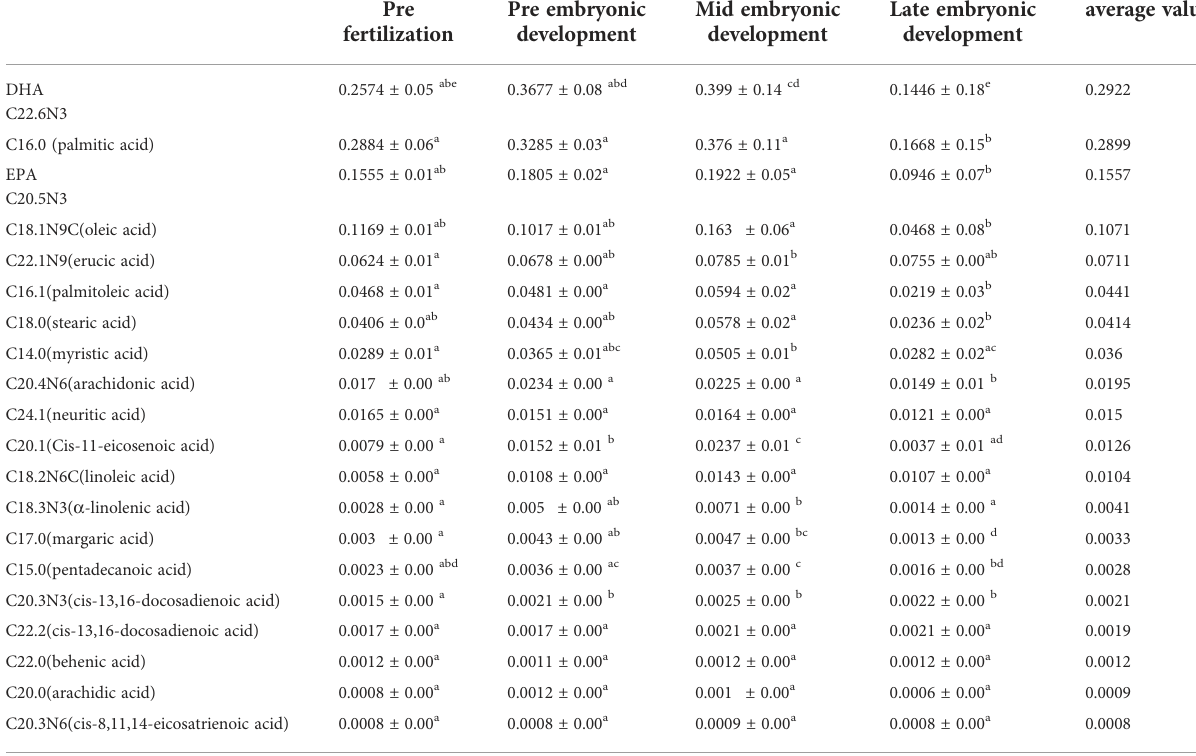
TABLE 4 Plasma fatty acids content of three samples of S. schlegelii in different developmental stages (g/100 g). Pre